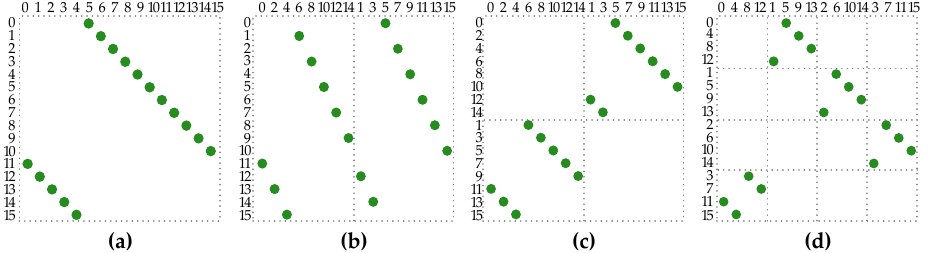
Figure 8. CPM splitting examples: ( a ) the original CPM, ( b ) original CPM with columns permuted for D = 2, ( c ) final permuted CPM for D = 2, and ( d ) final permuted CPM for D = 4.